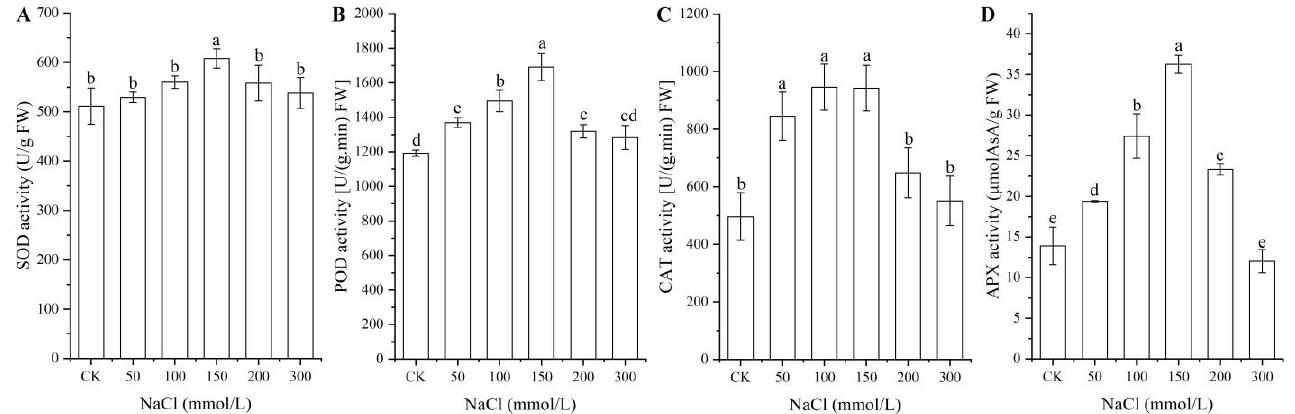
Figure 2. Changes in the activities of the four antioxidant enzymes SOD ( A ), POD ( B ), CAT ( C ), and APX ( D ) in A. venetum seeds at different NaCl treatments. Different letters represent a significant difference ( p < 0.05) among different NaCl treatments.